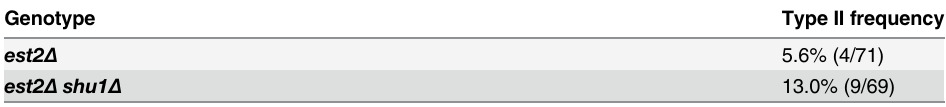
Table 2. Type II survivor frequencies in est2 Δ and est2 Δ shu1 Δ